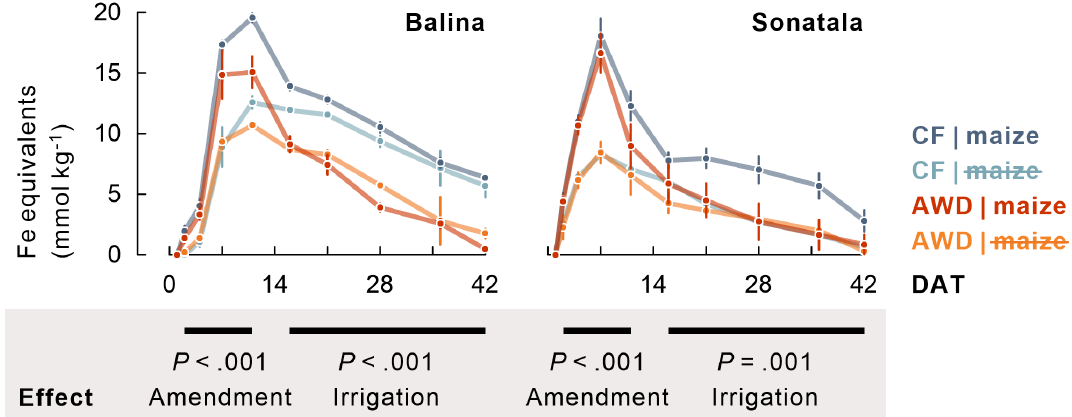
Figure 2. Maize addition stimulated reductive dissolution of Fe (average ± standard error of three or two replicates, calculated as sum of dissolved Fe and increments in dissolved Ca and Mg), and Fe 2 + disappeared to a larger extent from the soil solution under AWD than under CF in maize-amended pots. The P -values indicate the effect of maize addition on the time series between 2 and 11 DAT, and the effect of irrigation treatment in maize-amended pots on the time series between 16 and 42